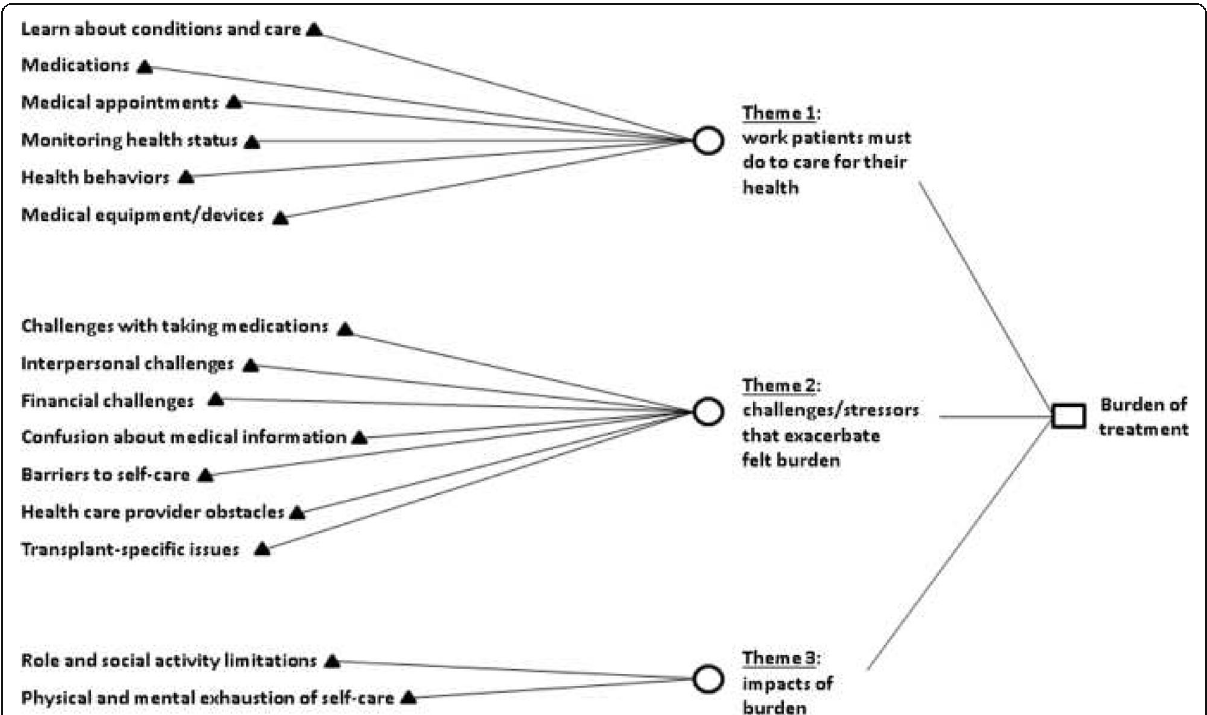
Fig. 1 A conceptual measurement framework of treatment burden after kidney